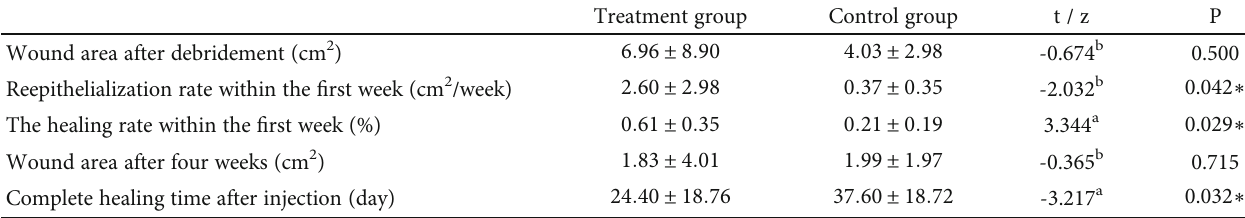
Table 2: The comparison of the treatment group and control group among fi ve patients with multiple